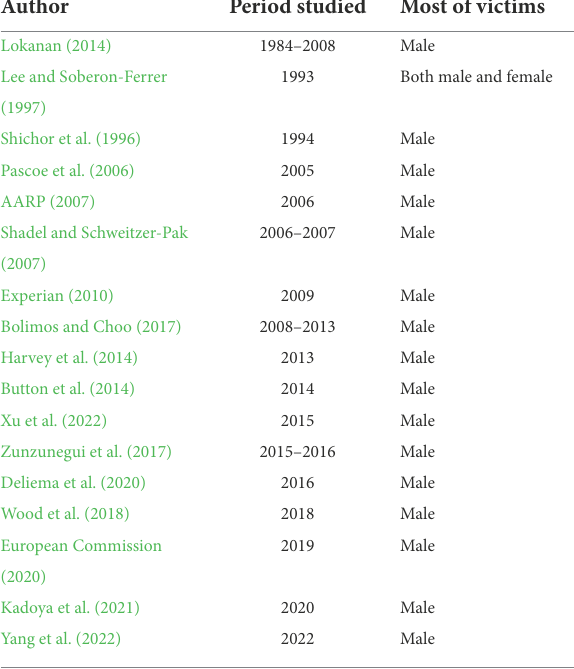
TABLE 2 Profiles of victims according to gender across time.